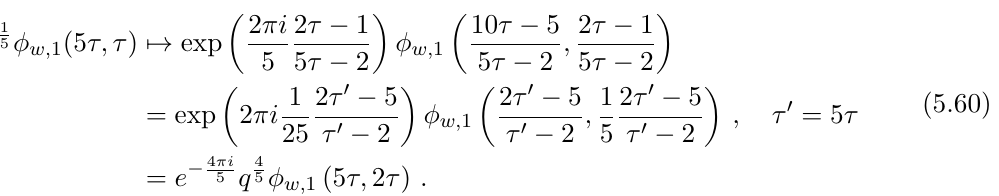
Figure 6 . The relations between the smooth genus one fibration X (2) non-commutative resolutions of the Jacobian fibration X (2) over P 2